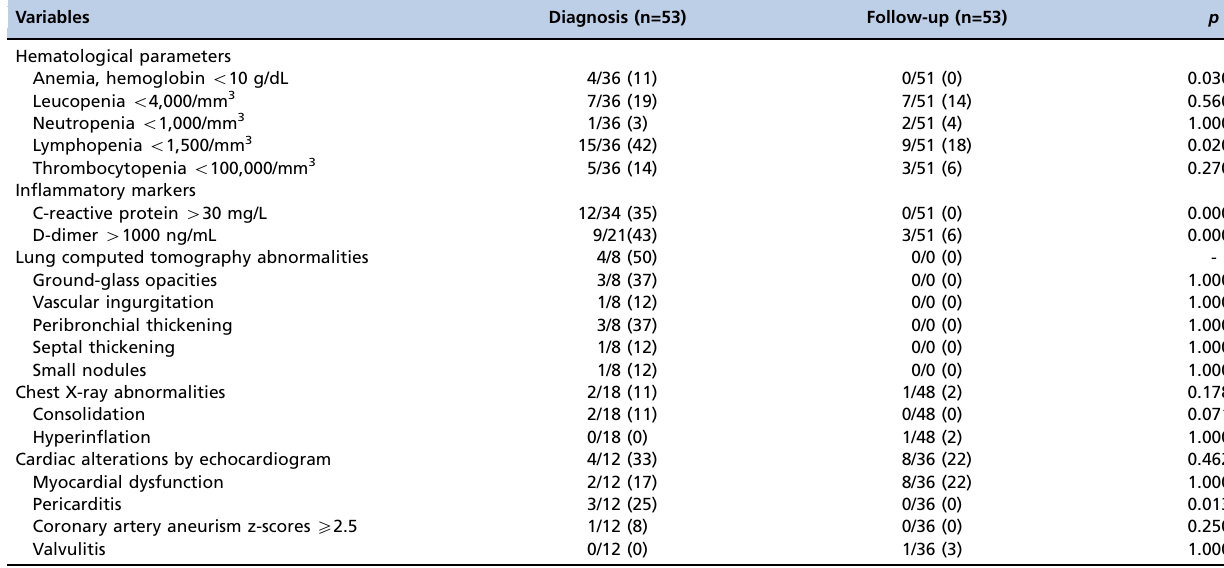
Table 2 - Laboratory tests and imaging abnormalities in pediatric laboratory-confirmed coronavirus disease (COVID-19) cases at diagnosis and longitudinal follow-up visit.